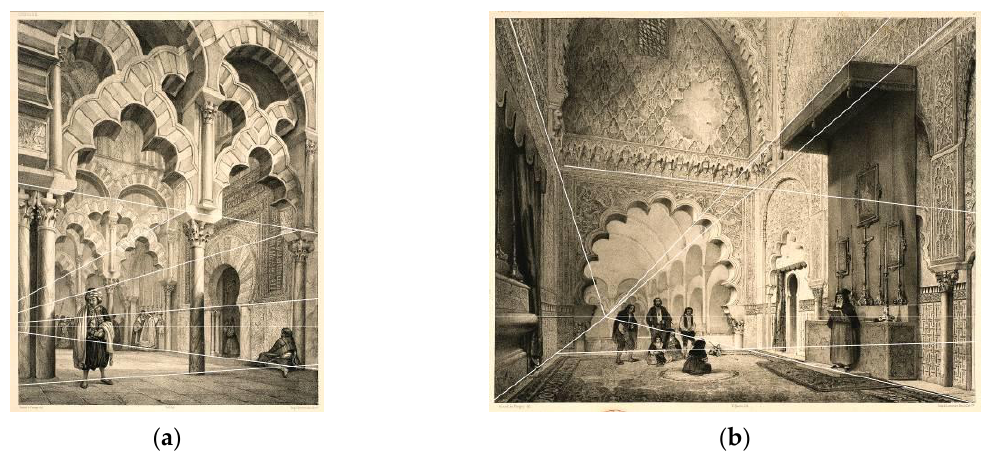
Figure 19. Location of horizon and vanishing lines in the Girault de Prangey’s perspectives: ( a ) Side view of the mihrab; ( b ) Royal Chapel view. Source: Own production .